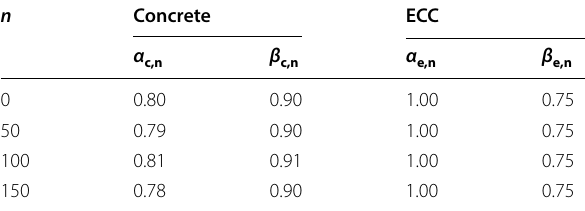
Table 11 Values of simplified coefficients α and β for freeze–thaw cycles e,n